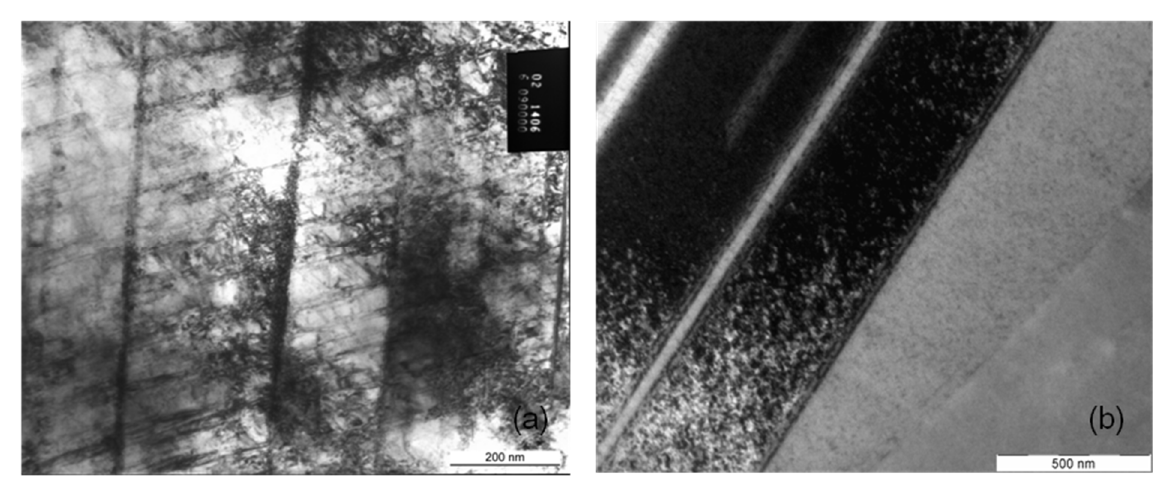
Figure 8 ( a ) Deformation structure and ( b ) deformation bands in an L605 stent bow (Coroflex ® Blue).